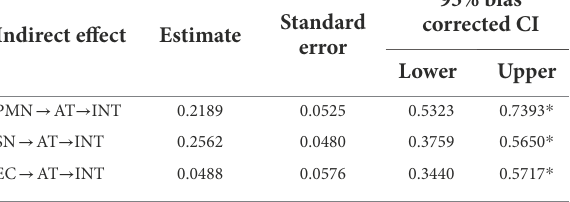
Table 6 and Figure 4 present the results of the independent T-test.